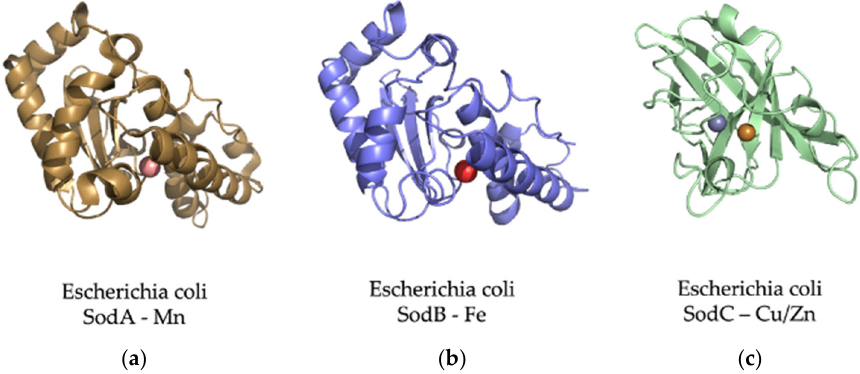
Figure 8. The adaptation of SOD proteins to different metal ions depending on their abundance. The SOD enzymes can convert the oxygen free radical (O 2 − ) into hydrogen peroxide (H 2 O 2 ) and water (H 2 O) [84]. ( a ) E. coli Mn ‐ superoxide dismutase protein. MnSOD is very important to protect